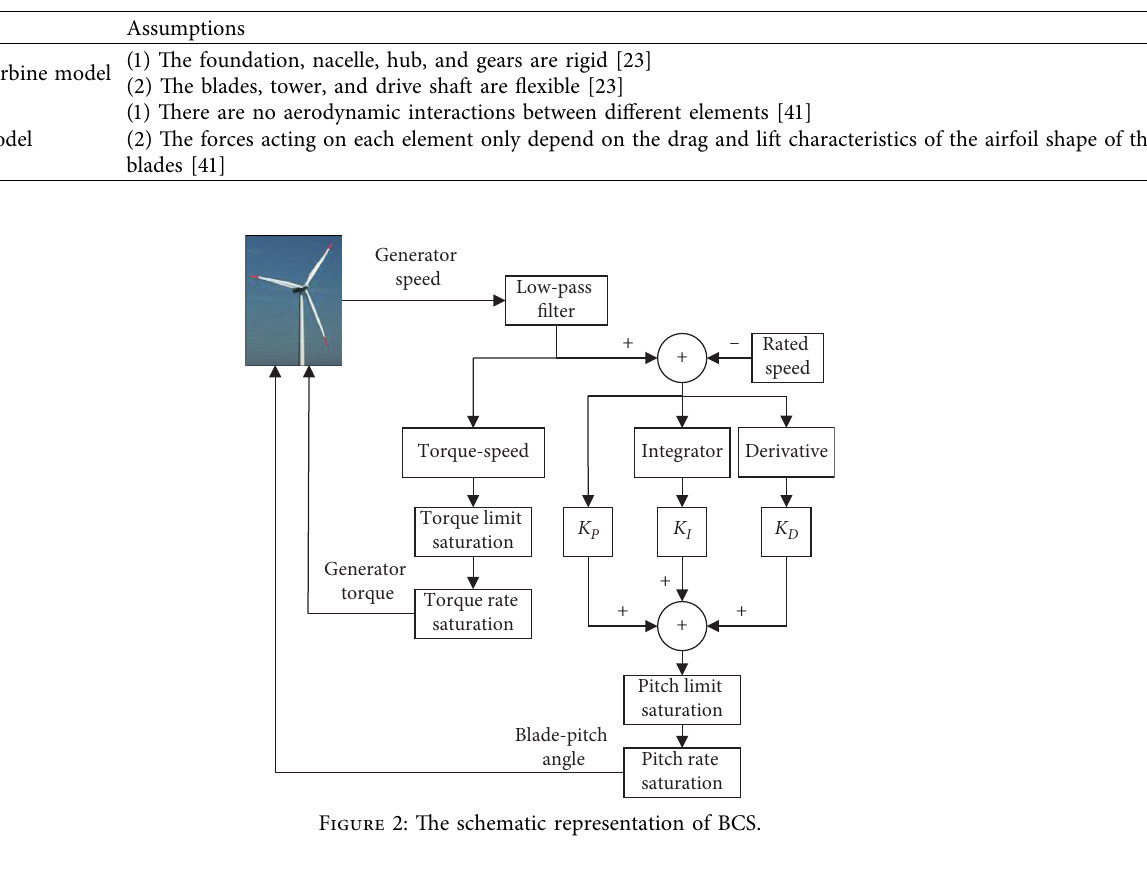
Table 2: Main assumptions.